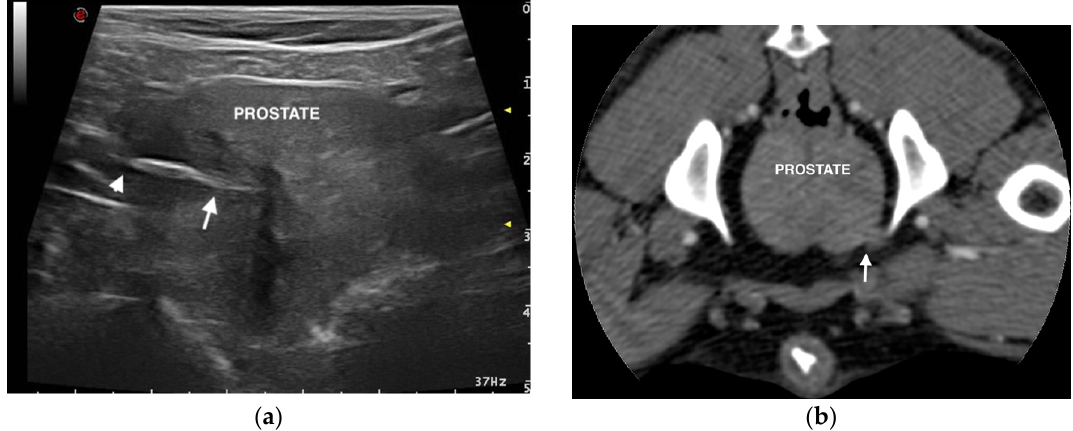
Figure 1. Ultrasonographic and computed tomographic (CT) images of the prostate: ( a ) Transverse ultrasonographic image of the prostate showing a spindle-shaped hyperechoic foreign body consistent with a grass awn; the tip (arrowhead) and barbs (arrow) of the awn are evident. ( b ) Transverse CT image of the prostate showing a capsular irregularity localized in the ventro-lateral right prostatic lobe, suggestive of periprostatic tissue reactions.